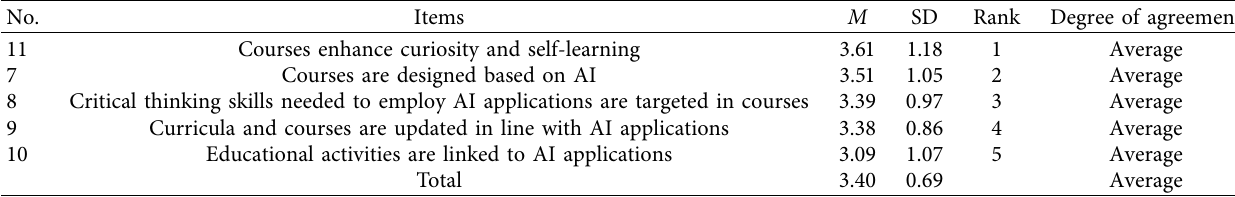
Table 5: Descriptives of the “courses” subdimension in descending order.